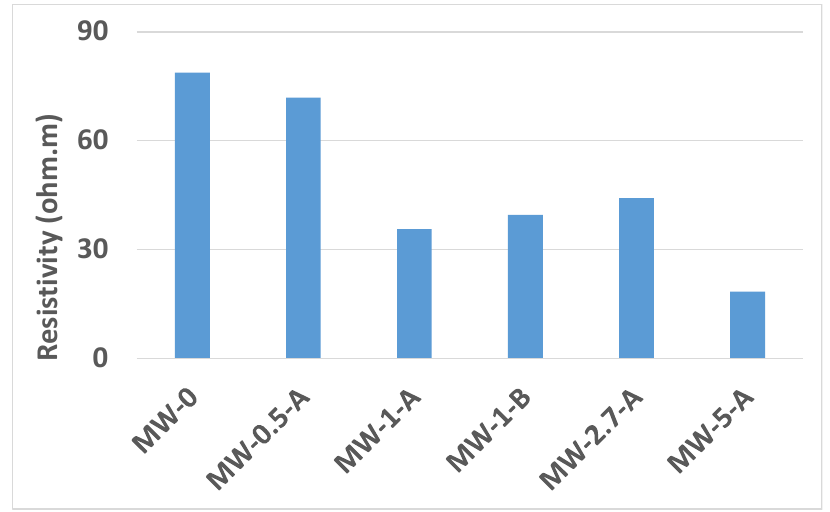
Figure 7. Resistivity of the different samples. Table 3. Chloride diffusion coefficients (10 − 12 m 2 /s).